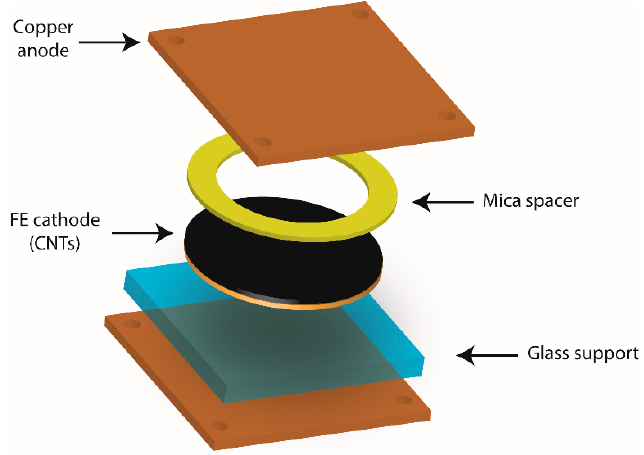
Figure 3. Schematic of the field emission device used in this research.